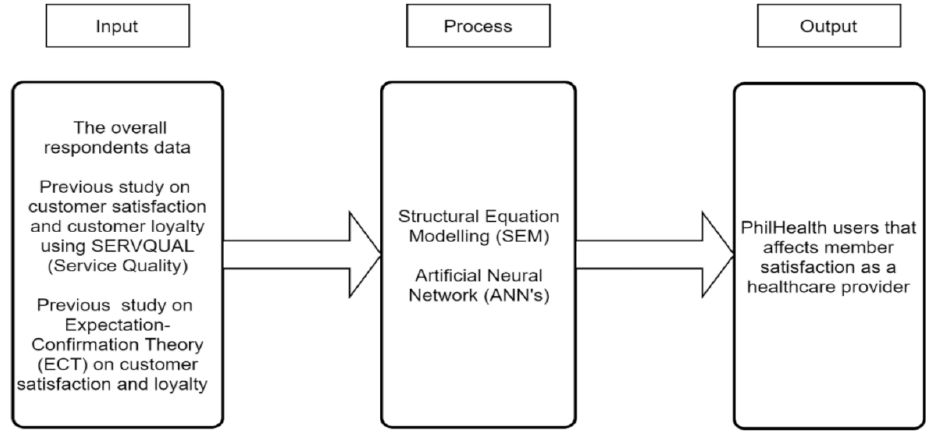
Figure 2. Input–Process–Output